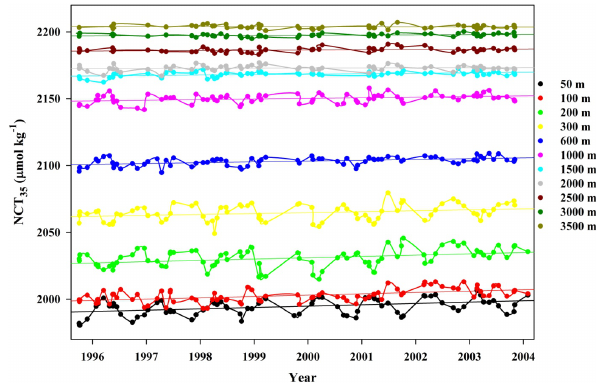
Fig. 5. Long-term trends of the observed water column pH in a total scale at 25 ◦ C, pH T , 25 for selected depths at ESTOC and for seawater in the mixed layer. The slope and standard deviation of the linear regressions are presented in Table